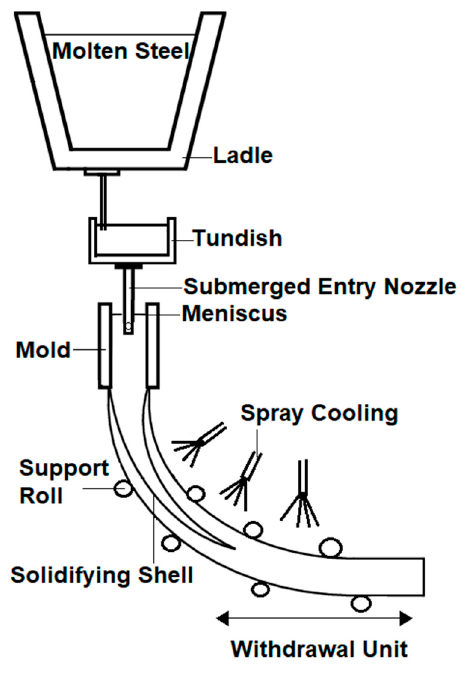
Figure 1. Schematic of a continuous casting process.